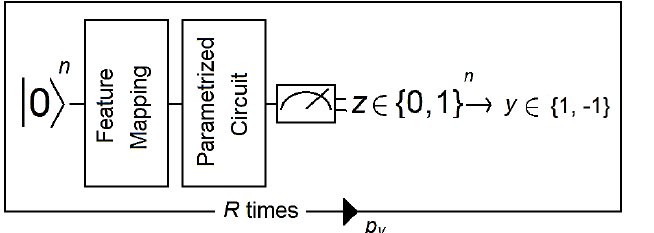
Figure 3. The circuit takes a reference quantum state and applies a feature map followed by a para- metrized circuit. Then, the output of the parametrized circuit is measured, and the resulting bit string z is mapped to a label y (1 or − 1 in this example). A distribution is generated by running the circuit R times. Then, the expectation value p y is estimated for all labels, from which the final label is deduced. Figure adapted from [40].